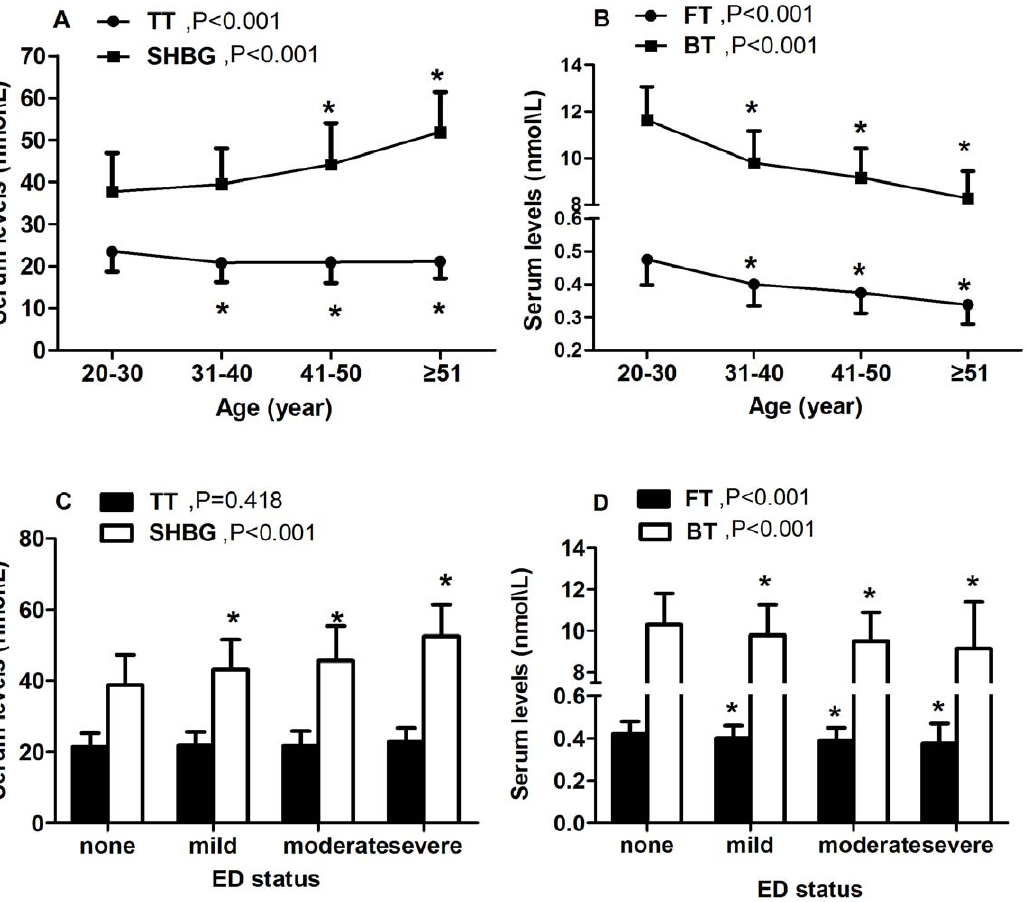
Figure 3. Testosterone and SHBG levels across ages and ED status. Panels A and B. Changes of TT, SHBG, FT, BT by each decade of age; Panels C and D. Association of TT, SHBG, FT, BT with ED status. P value is obtained by one-way analysis of variance (ANOVA). Student-Newman-Keuls test is used for multiple comparisons; asterisk in panels A and B stands for P , 0.05 compared with the 20–30 yr age group, whereas in panels C and D stands for P , 0.05 compared with the none-ED group. Dots represent median values of sex hormones, while bars represent the 25–75th percentiles. Abbreviations: ED, erectile dysfunction; SHBG, sex hormone-binding globulin; TT, total testosterone; FT, free testosterone; BT, bioavailable testosterone. Testosterone value.